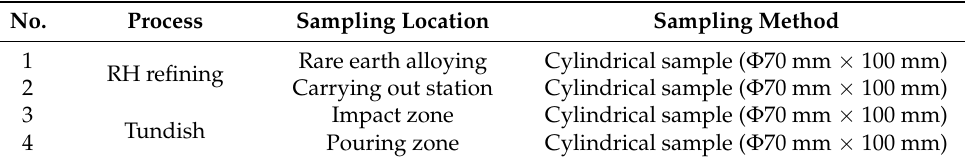
Table 3. Sampling plan.